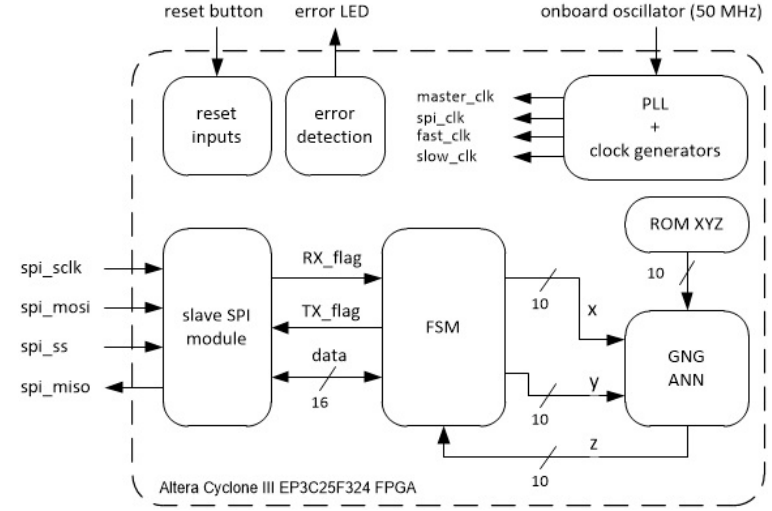
Figure 3. Block scheme of the virtual anemometer’s field programmable gate array (FPGA) implementation.